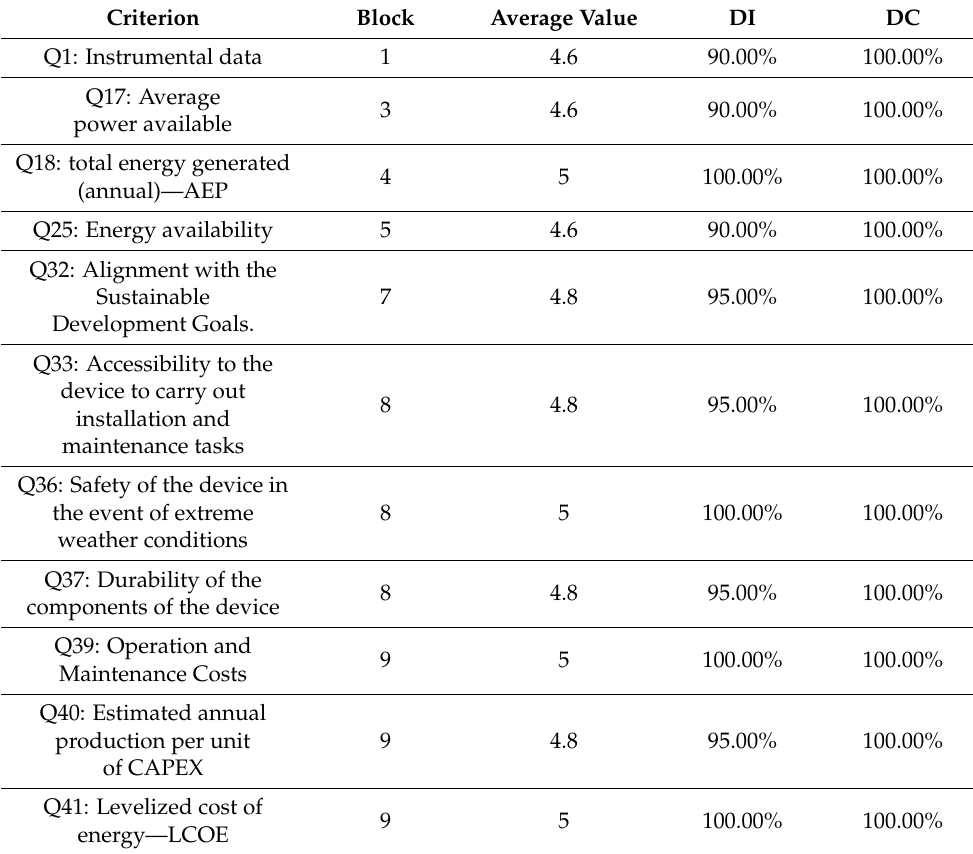
Table 11. Criteria meeting DI ≥ 90% and DC ≥ 90% values. Business/technology